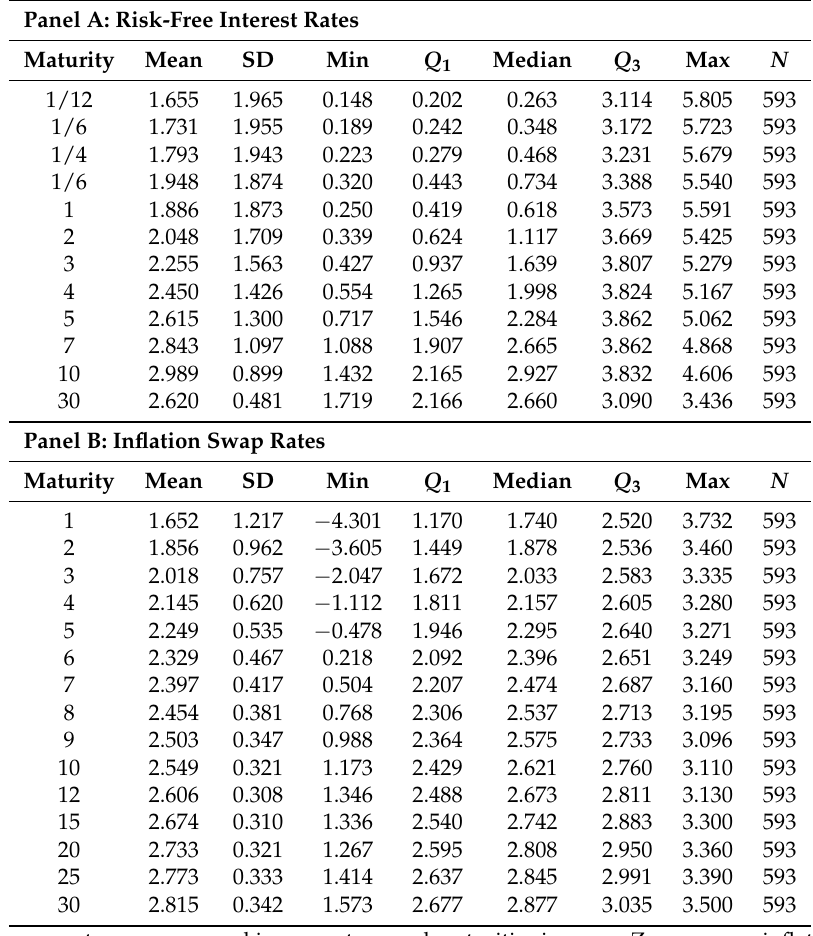
Table 2. Summary statistics for risk-free interest rates and inflation swap